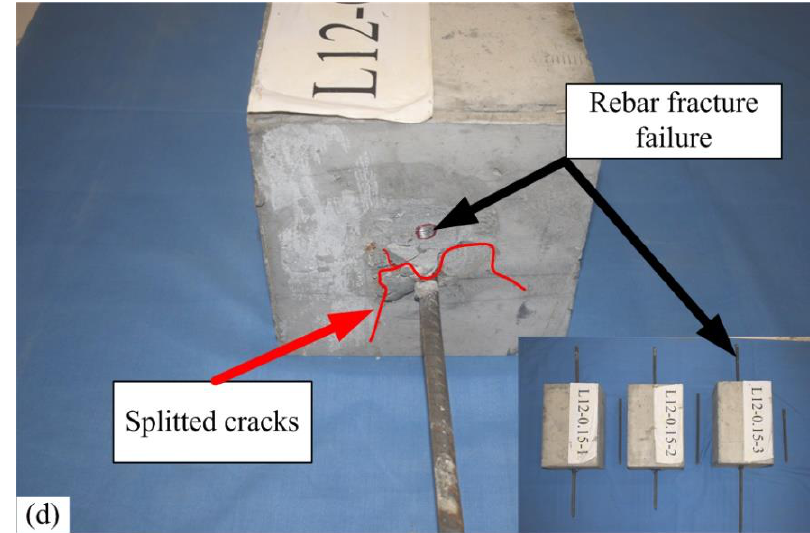
Figure 6. Failure modes of the short-lapped-rebar splices ( a ) Rebar fracture failure (L20-0.15) ( b ) Rebar pull-out failure (L20-0.1) ( c ) Rebar pull-out failure (L20-0.05) ( d ) Rebar fracture failure (L12-0.15).